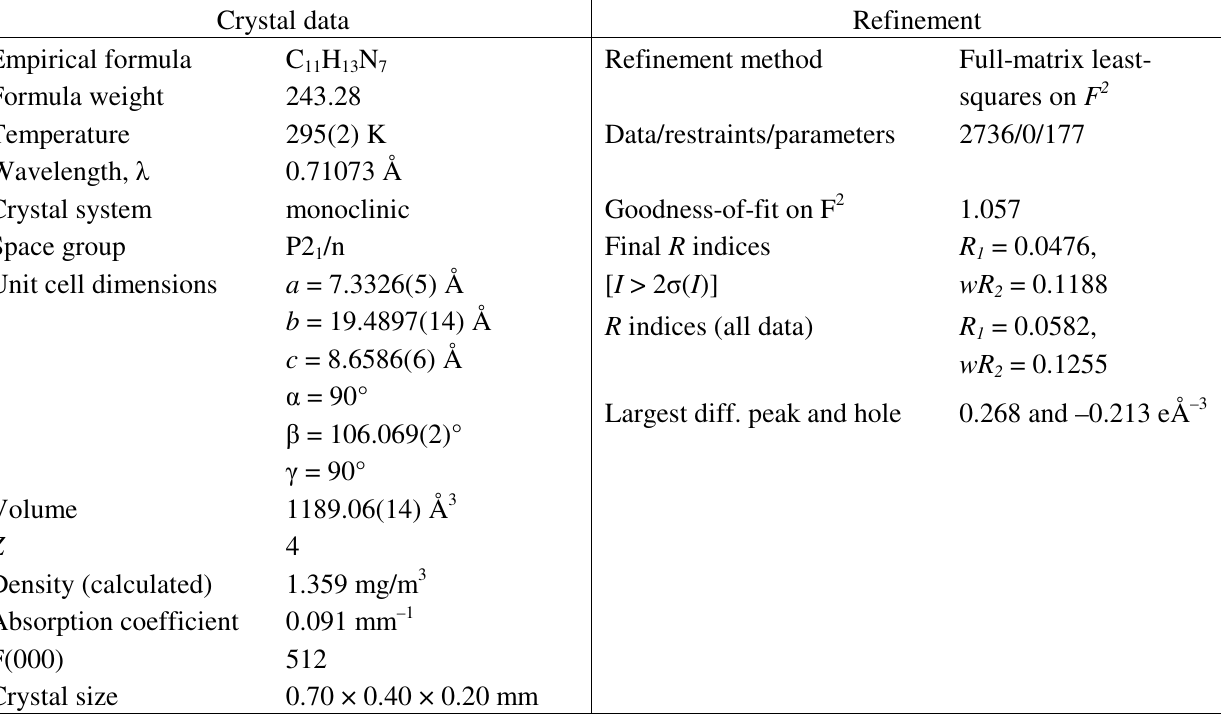
Table 1. Crystal data and structure refinement for